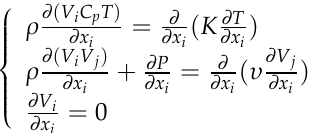
Figure 4. Batteries 2020 , 6 , x FOR PEER REVIEW